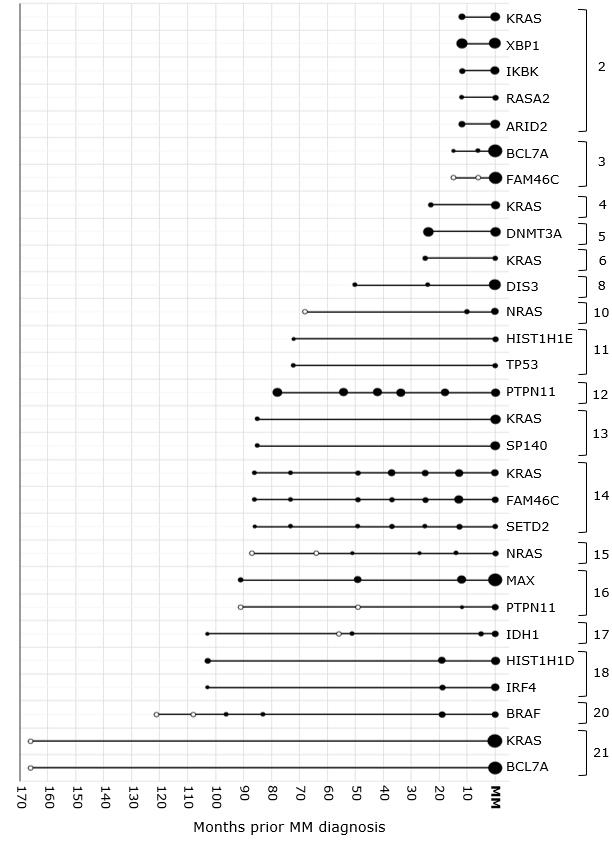
Figure 1. Overview of detected variants in the progression from precursor stage(s) to MM. In 17 patients, the MM BM smear had at least one variant. In 16 of the 21 patients, variants detected in the MM phase were already present in the precursor stage. A significantly detected variant is indicated by a black dot. The size of the dot is representative for the VAF. In BM samples in which the variant was not detected, the dot is open. The time on the x-axis is given in months prior to the MM diagnosis. Mutations found in the same patient were indicated with an accolade and patient number. BM: bone marrow; VAF: variant allele frequency; MM: multiple myeloma.